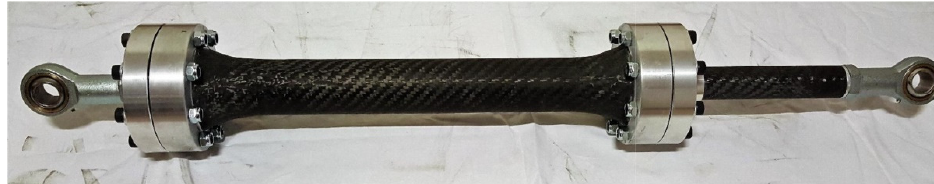
Figure 5. An actuator prototype designed by Solazzi [37].